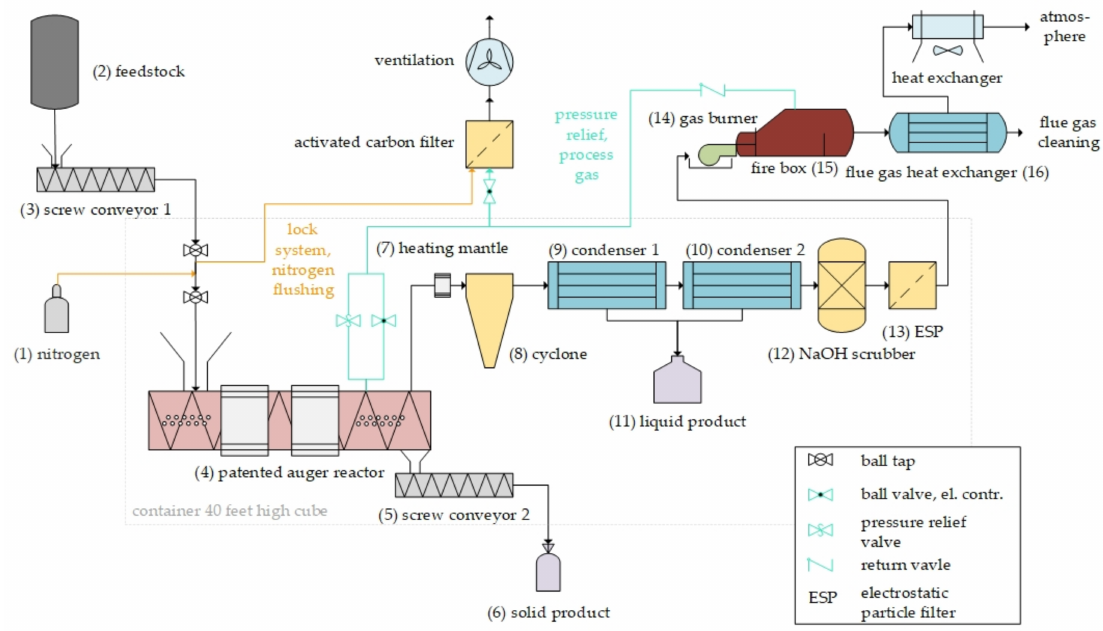
Figure 1. Process flow diagram of the iCycle ® pilot plant (thermochemical conversion